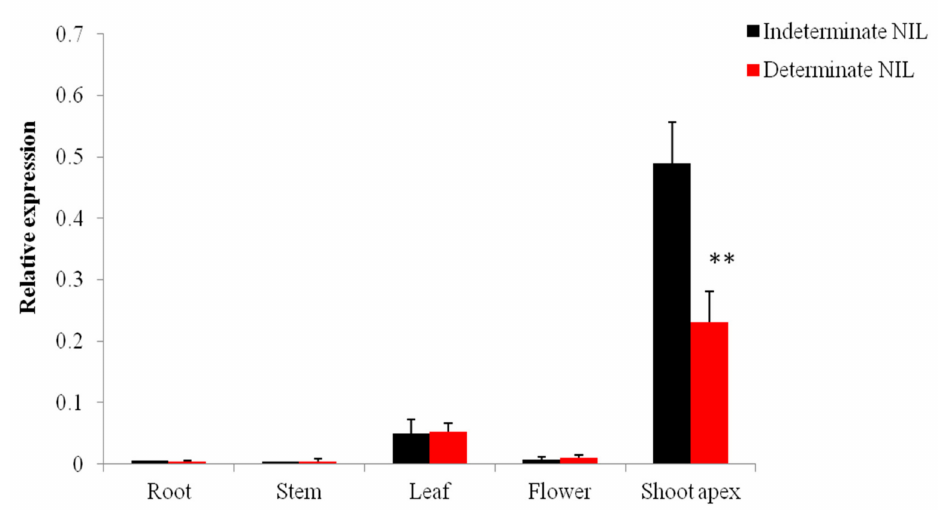
Figure 2. Expression of the BnA10.TFL1 gene in di ff erent tissues of indeterminate and determinate near-isogenic lines (NIL) in B. napus . The error bars show the standard errors from three biological replicates. ** indicates significant di ff erences at p <